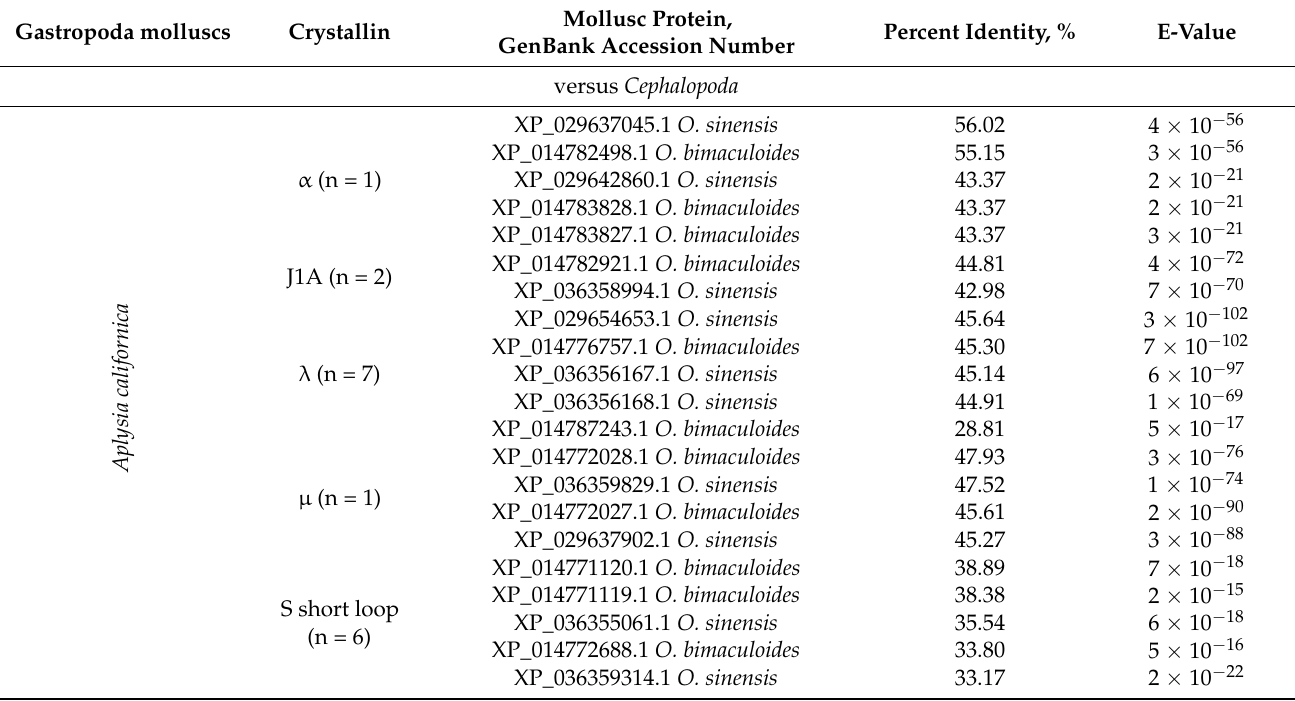
Table 2. Percent identity of Gastropoda mollusc crystallins versus Cephalopoda and Bivalvia mollusc crystallins by BLAST. Mollusc Gastropoda molluscs Crystallin